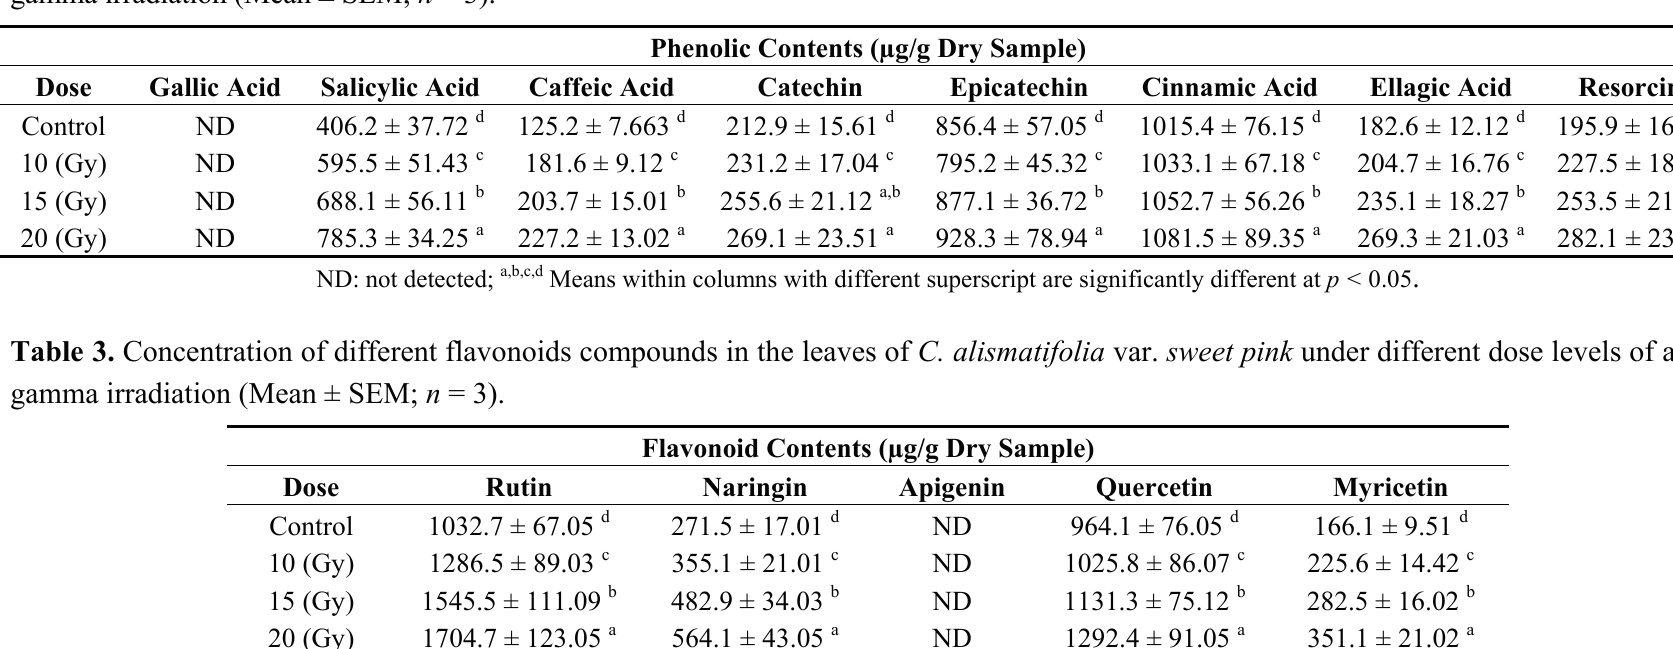
Table 2. Concentration of different phenolic compounds in the leaves of C. alismatifolia var. sweet pink under different dose levels of acute gamma irradiation (Mean ± SEM; n = 3).